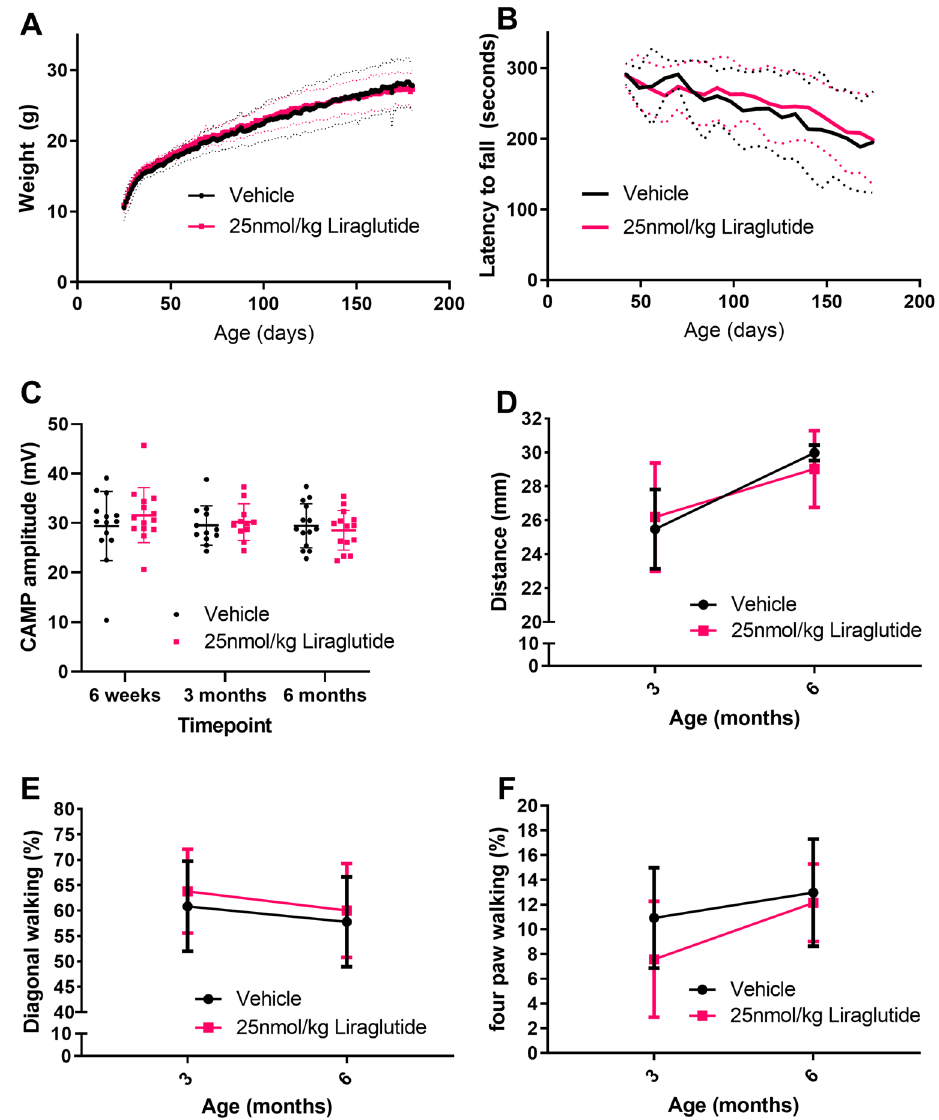
Figure 1. Liraglutide, dosed once daily at 25 nmol/kg IP does not slow disease progression in a TDP-43 Q331K transgenic mouse model of ALS. ( A ) Daily average body weight (mean ± SD) of mice dosed with vehicle or liraglutide, once daily, ip from 25 days to 6 months of age. As expected, TDP-43 Q331K mice gain weight through to 6 months of age. No significant difference was seen in bodyweight data between the two groups (n = 14 per group, two-way ANOVA with repeated measures P = 0.7442). Average shown by thick line, ± SD shown by thin dashed lines ( B ) Rotarod data shown as average latency to fall (mean ± SD) from 50 to 180 days of age. Performance on rotarod declined over time as expected from the model but there was no significant difference between the two dose groups (n = 14 per group, two-way ANOVA with repeated measures P = 0.5741). ( C ) Compound muscle action potential (CMAP) amplitude at 6 weeks, 3 months and 6 months of age shown as individual values with mean ± SD. There is no significant difference in CMAP between groups (n = 14 per group, two-way ANOVA with repeated measures P = 0.5655). ( D ) Hindlimb base of support (mean ± SD) at 3 and 6 months of age from gait analysis shows no significant difference between dose groups (n = 7 per group, two- way ANOVA P = 0.8974 NS). ( E ) Percentage of time spent on diagonal walking (mean ± SD) at 3 and 6 months of age (n = 7 per group, two-way ANOVA P = 0.5215 NS). ( F ) Percentage of time spent on four paws (mean ± SD) at 3 and 6 months of age (n = 7 per group, two-way ANOVA P = 0.3100